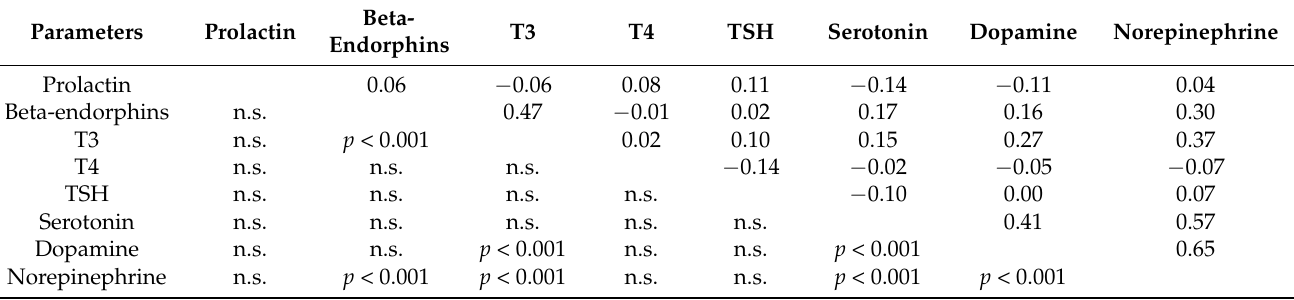
Table 2. Correlations (above the diagonal) and their coefficient (below the diagonal, p -value) between the variables